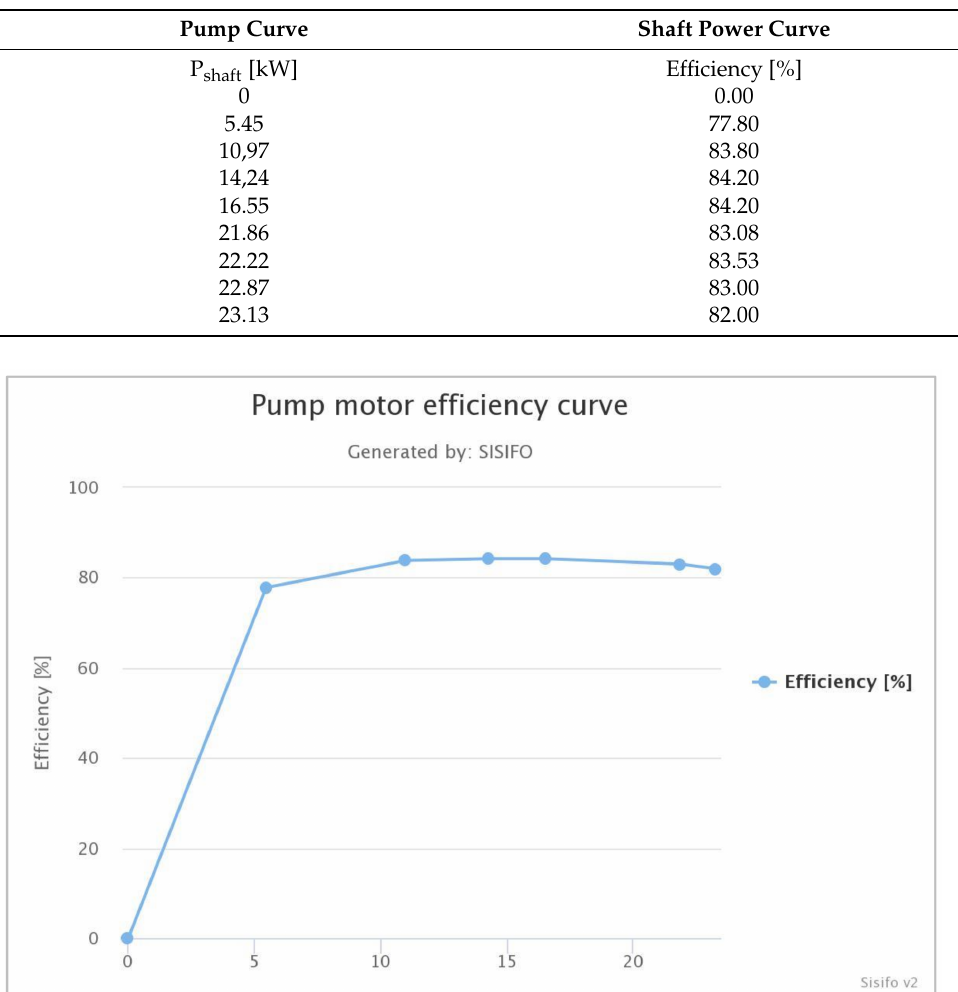
Table 2. Input data for pump motor.